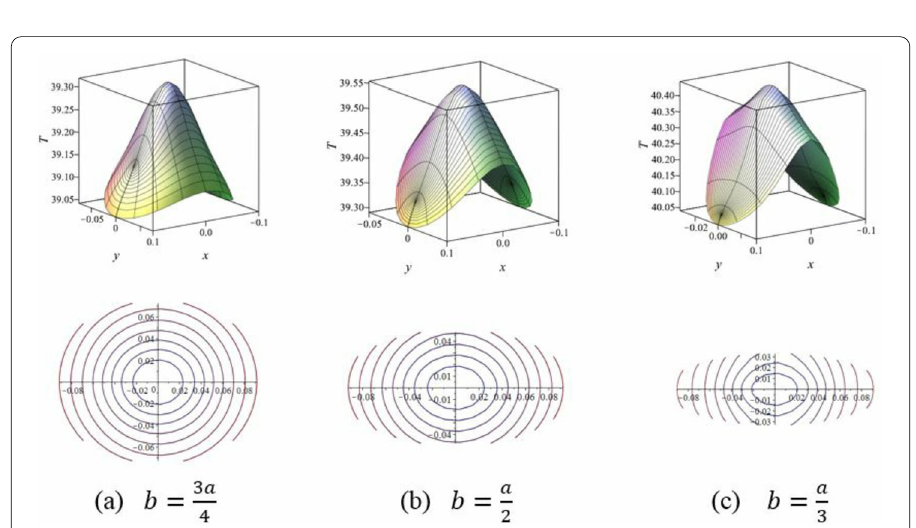
Figure 5 Temperature distribution. Temperature distribution on the cross section z = 5 cm in a full wave cycle at time t = 123 s obtained from the model with three aspect ratios of b / a = 3/4,1/2 and 1/3 for slip length of 0.1 and the semi-major axis of a = 0.1